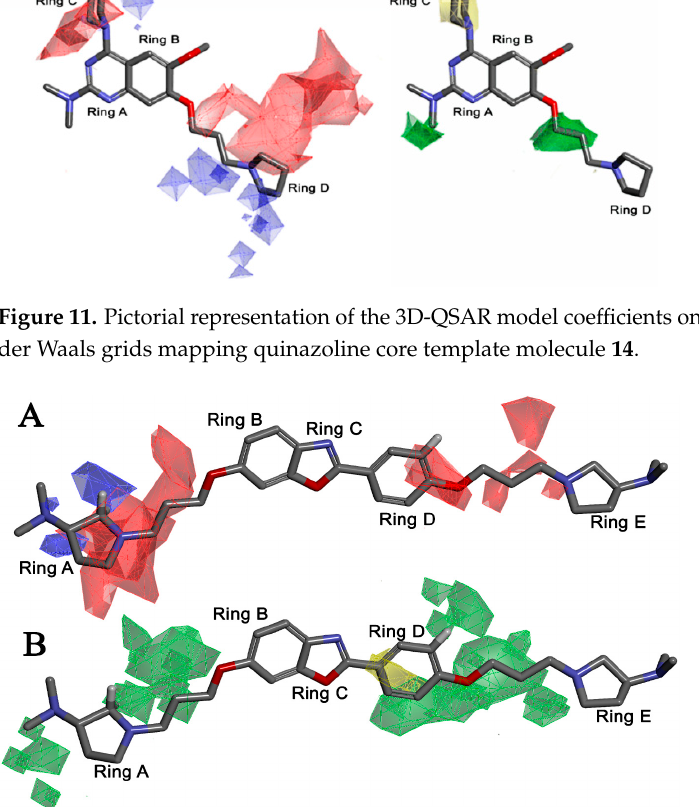
Figure 12. Pictorial representation of the 3D-QSAR model coefficients on ( A ) electrostatic potential and ( B ) Van der Waals (VDW) grid mapping benzoxazole core template molecule 32.